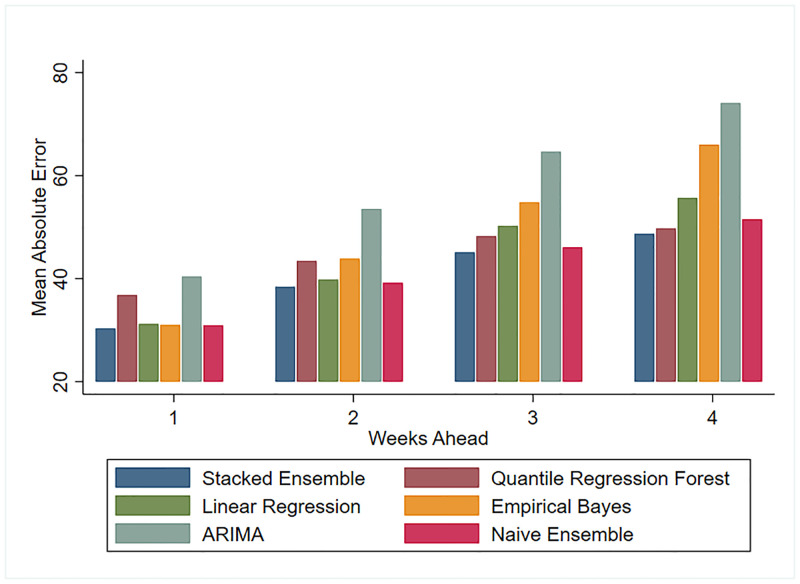
MAE comparison for test seasons 2012-2018.